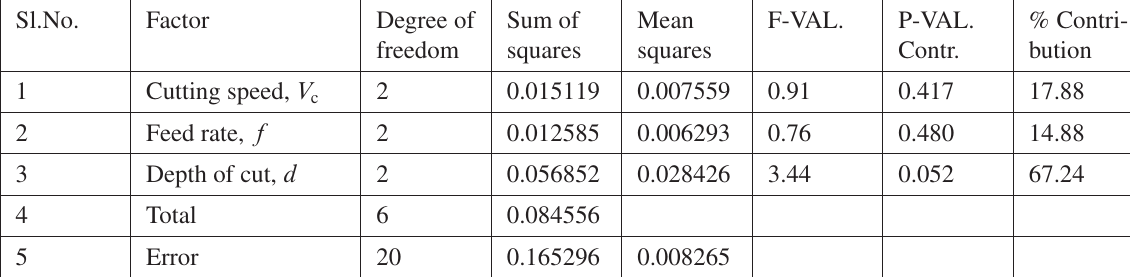
Table 3. ANOVA for Crater wear ( K T